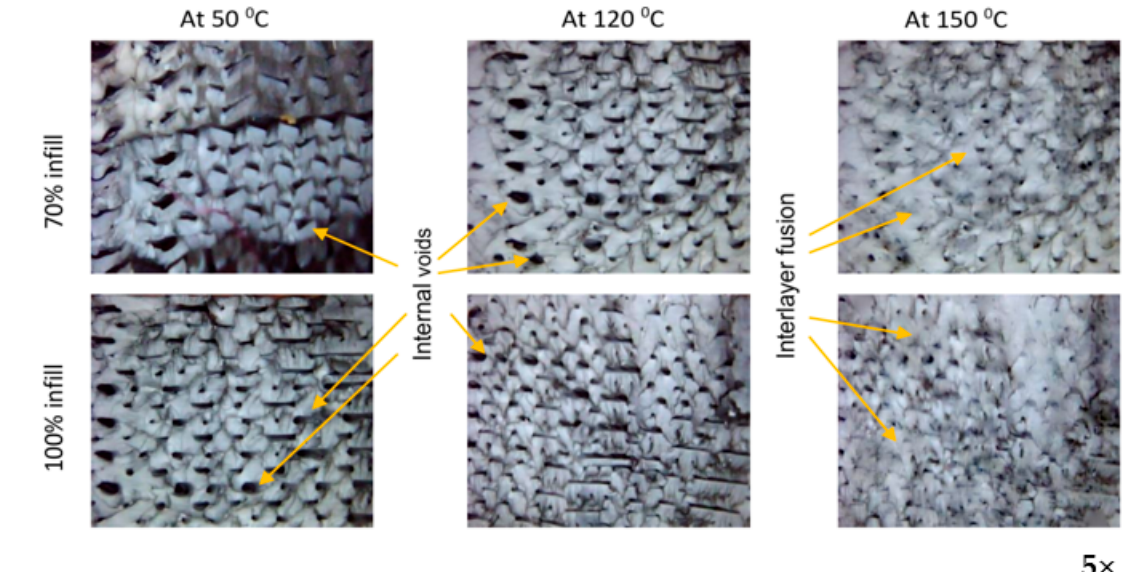
Figure 7. Microscopic images of the cross-section of the samples at different temperatures for heat treatment.